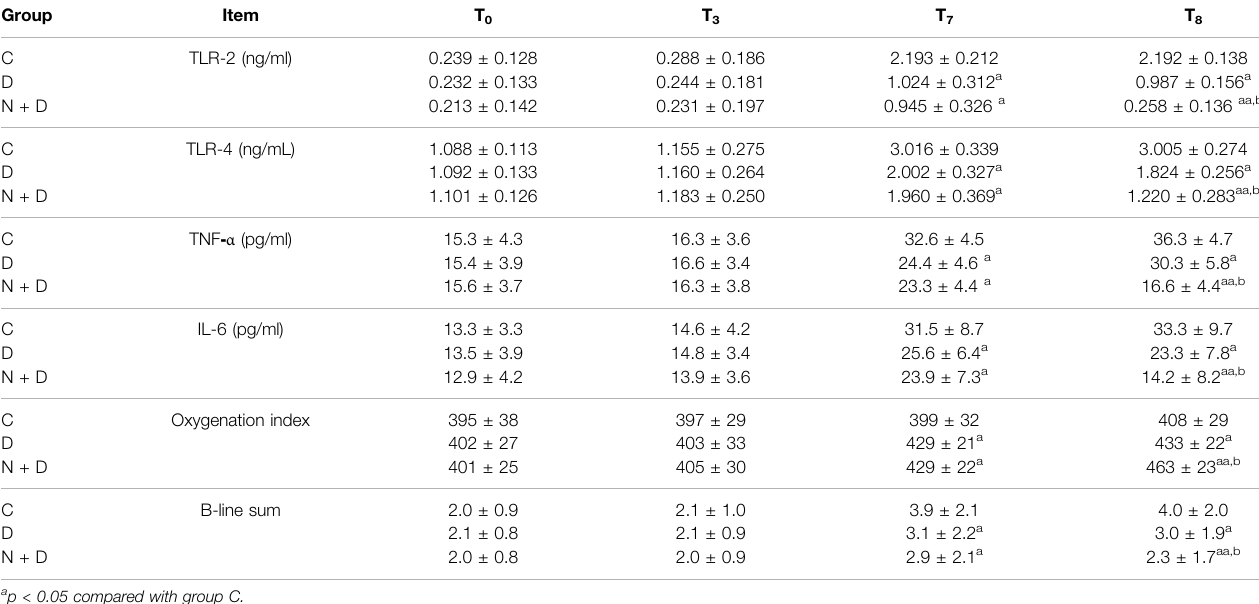
TABLE 3 | In fl ammatory factor, oxygenation index, and B-line sum indicator at different time points in each group ( (cid:1) x ±s ). Group